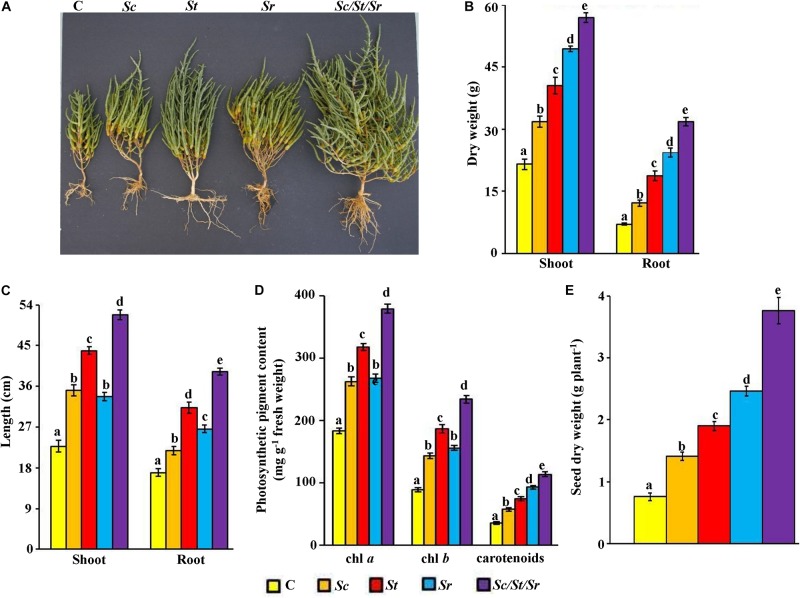
Effect of the rhizosphere-competent actinobacterial isolates on growth and seed yield of Salicornia bigelovii. Effect of the treatment of the rhizosphere-competent auxin-, polyamine-, and ACCD-producing isolates on (A) performance; (B) dry weight and (C) length of shoot and root tissues; (D) photosynthetic pigment contents of chl a, chl b and carotenoids; and (E) dry weight of seeds, of S. bigelovii. In (A–D), the figure, dry weight and length of shoot and root tissues, and photosynthetic pigments were measured at 12 wps the seeds; whereas dry weight of seeds was measured at 20 wps. Values are means of 16 replicates for each sampling from two independent experiments. Mean values followed by different letters are significantly (P < 0.05) different from each other according to Fisher’s Protected LSD Test. Bars represent standard error. C, control (autoclaved non-inoculated oat bran); Sc, auxin-producing isolate #21 (S. chartreusis UAE1); St, polyamine-producing isolate #7 (S. tritolerans RAK1); Sr, ACCD-producing isolate #11 (S. rochei RAMS1); Sc/St/Sr, consortium of the three rhizosphere-competent isolates. ACCD, 1-aminocyclopropane-1-carboxylic deaminase; chl, chlorophyll; wps, weeks post-sowing.